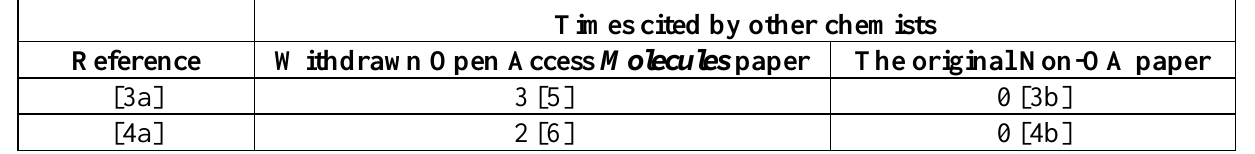
Table 1 . Citation of withdrawn Open Access (OA) papers and the original non-Open Access (non-OA) versions